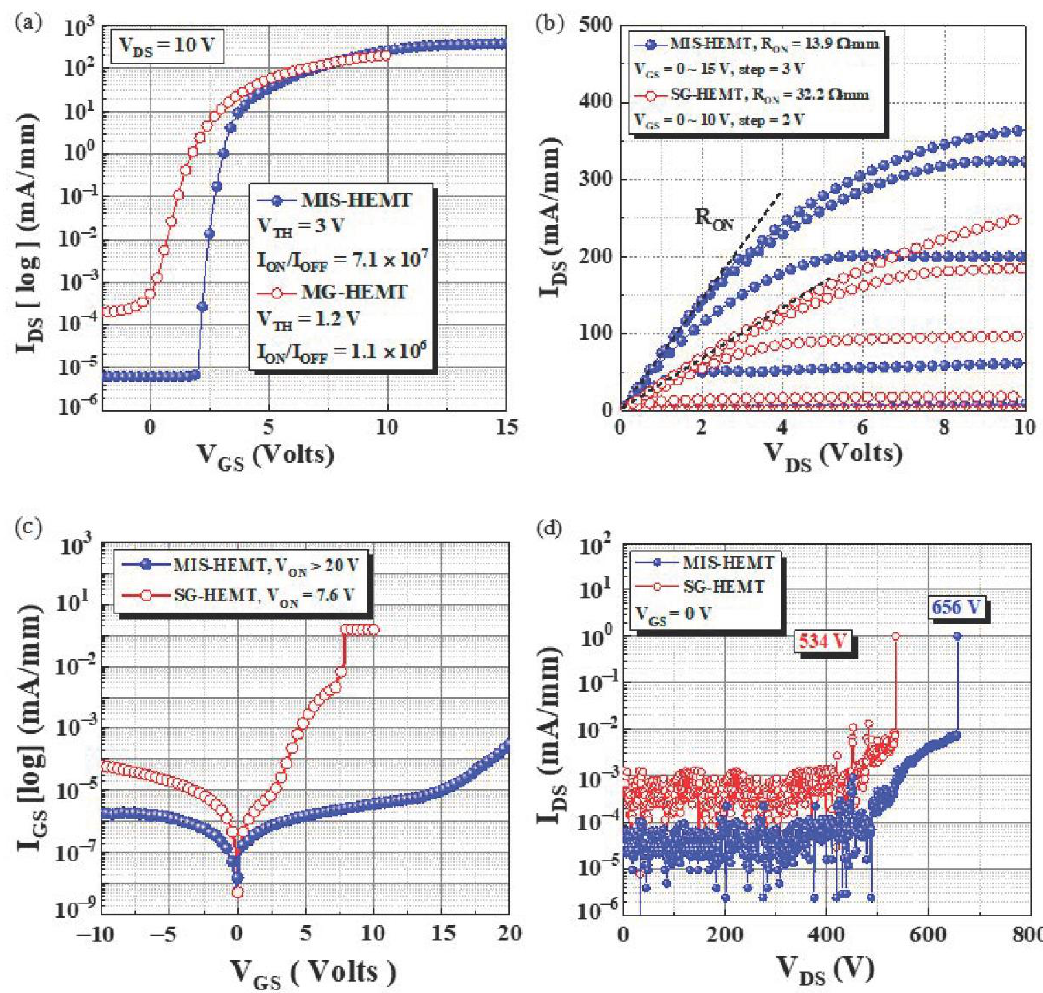
Figure 3. ( a ) Log-scale I DS – V GS transfer characteristics, ( b ) I DS – V DS output characteristics, ( c ) I GS – V GS characteristics, and ( d ) off-state breakdown voltages of the MIS-HEMT and SG-HEMT.